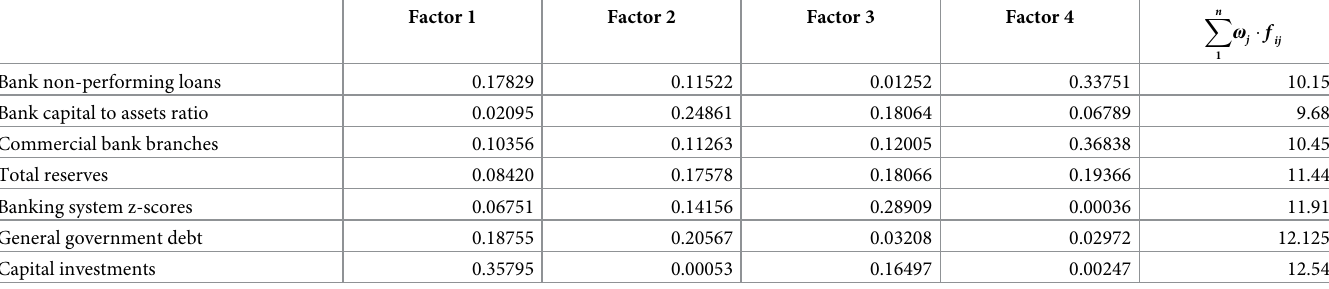
Table 4. The contribution of financial and budgetary variables to each factor.